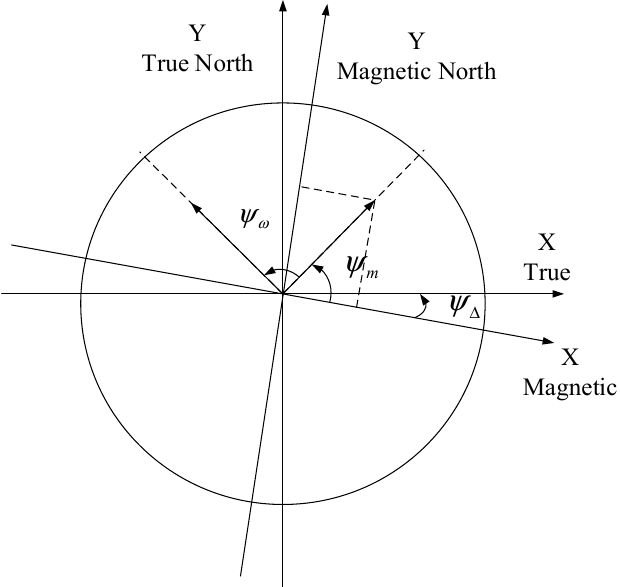
Figure 3. Heading angle conversion